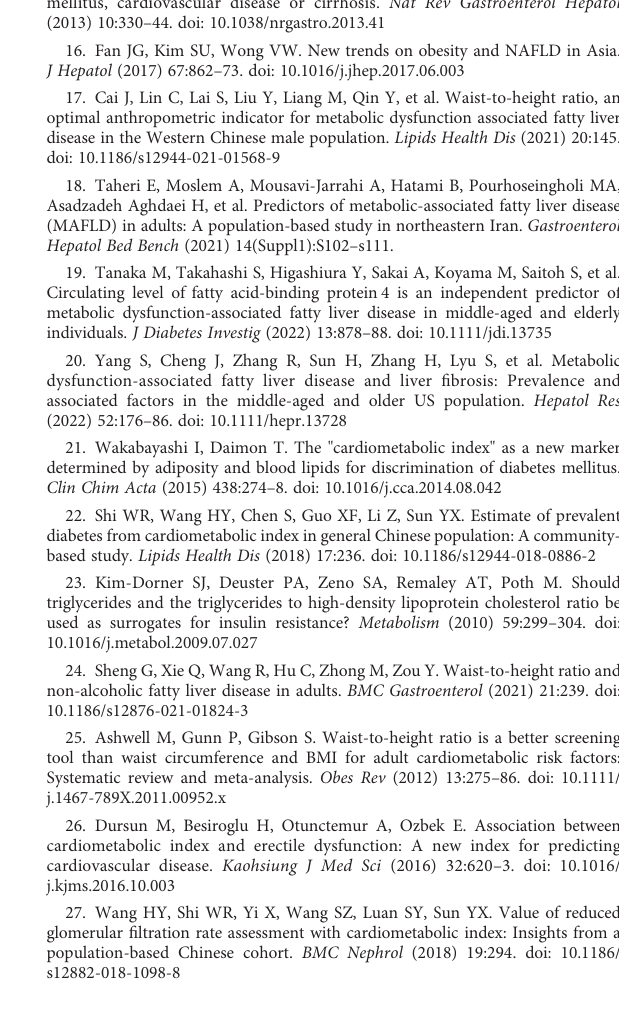
SUPPLEMENTARY TABLE 1 Analysis of the ROC curve results of CMI, WC, BMI, TG/HDL-C, and TG. SUPPLEMENTARY TABLE 2 Correlation between CMI and MAFLD related